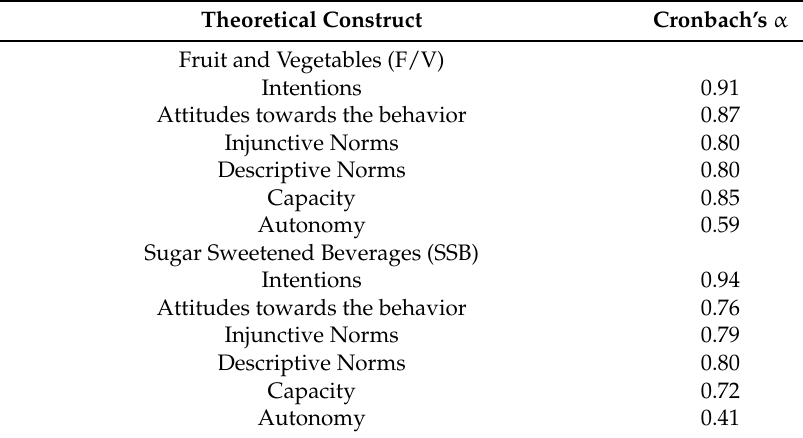
Table 4. A summary of the reliability